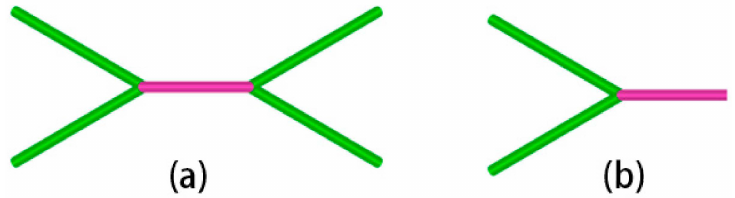
Figure 13. Dislocation structure. ( a ) Double-branch structure; and ( b ) single-branch